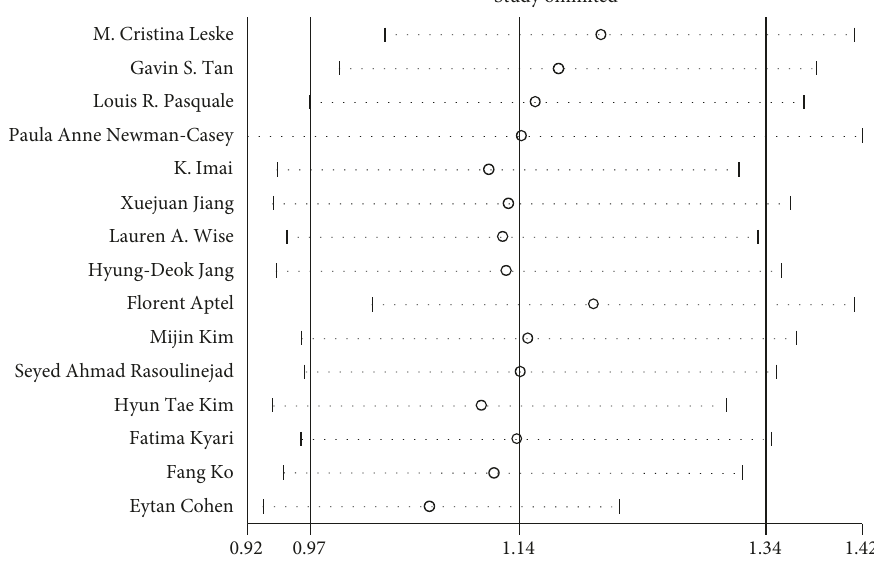
Figure 4: Sensitivity analysis of the association between adiposity and